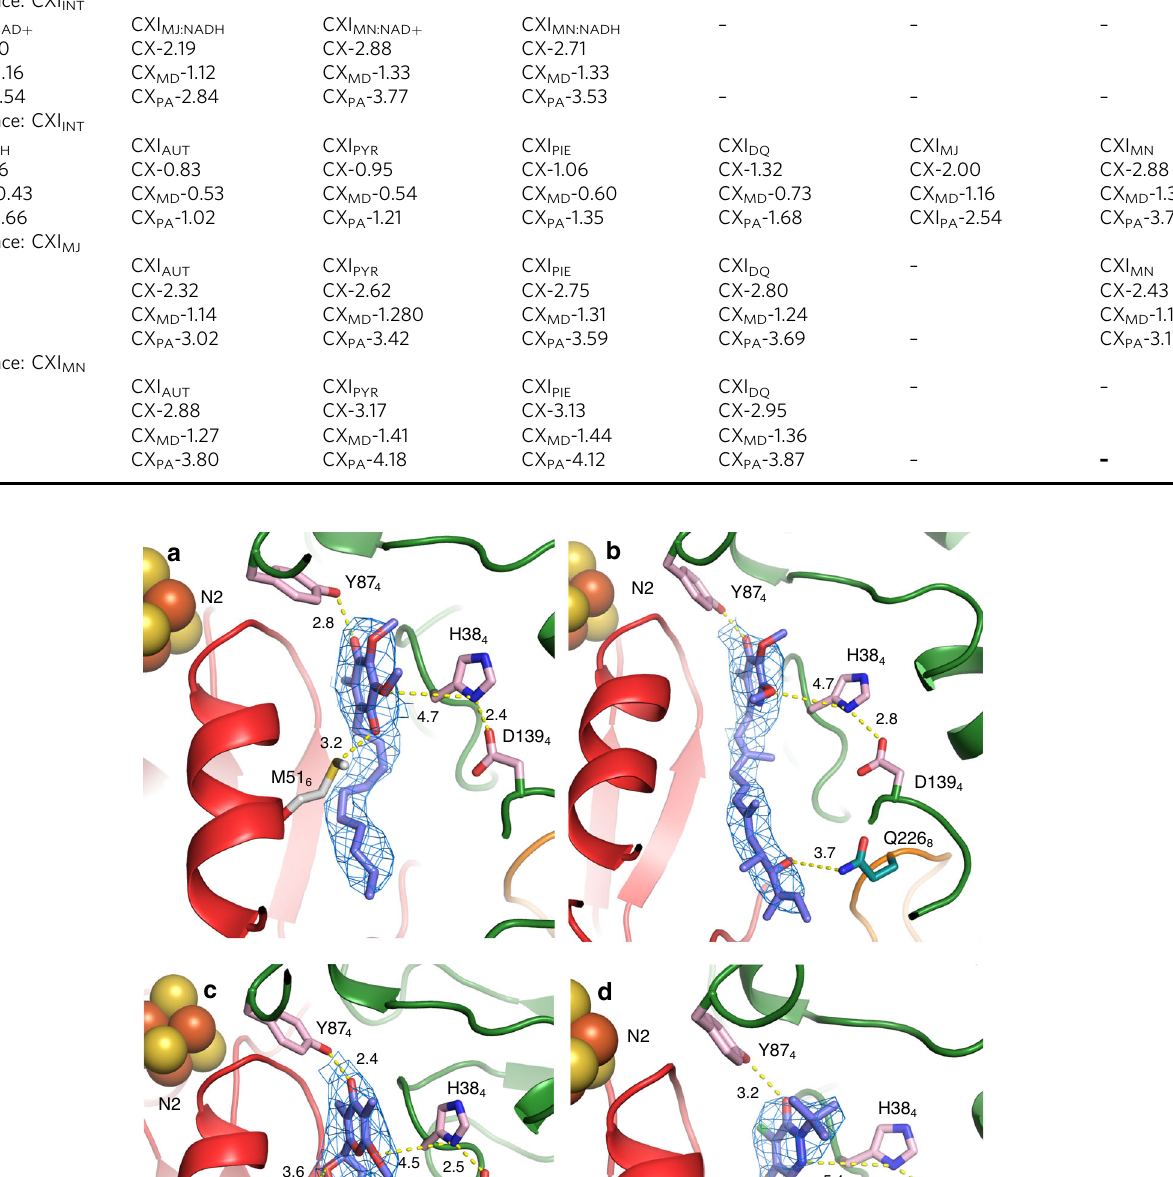
Table 1 The RMSD values for the aligned structures of complex I. Structures of complex I aligned by C α atoms of their membrane domains. CX, CX MD and CX PA stand for the whole complex, membrane domain and peripheral arm, respectively.